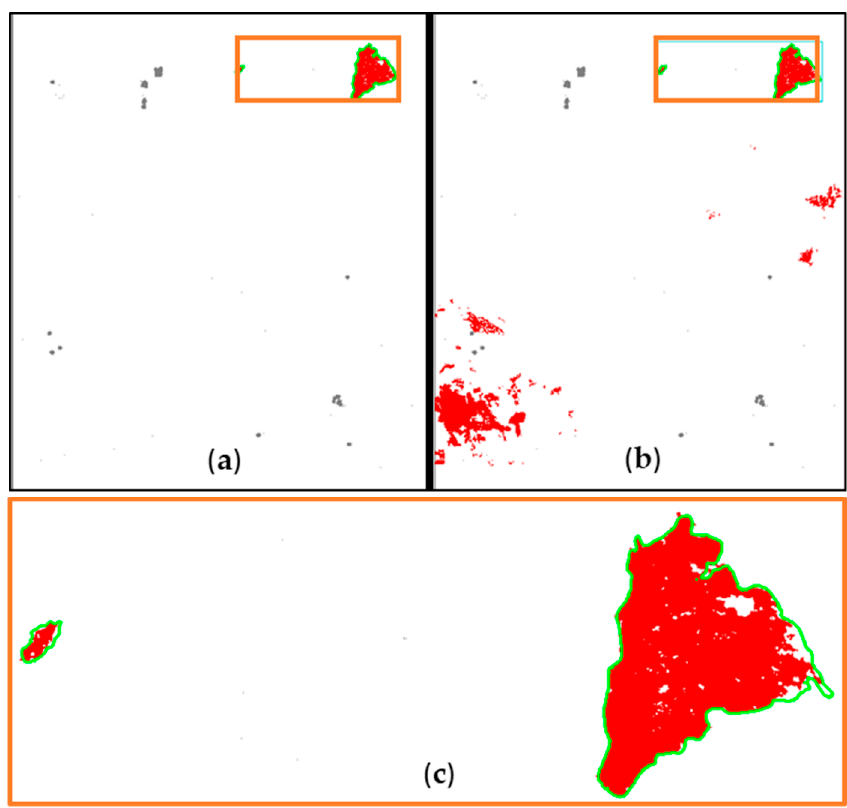
Figure 12. AUTOBAM-burned areas maps for the Castile and León case study; ( a ) performing the ISODATA classification step; ( b ) without performing the ISODATA classification step. Green lines represent the perimeter of the CEMS-derived burned areas. The orange box delineates the CEMS-derived area of interest. Panel ( c ) is a zoom on the CEMS-derived area of interest.